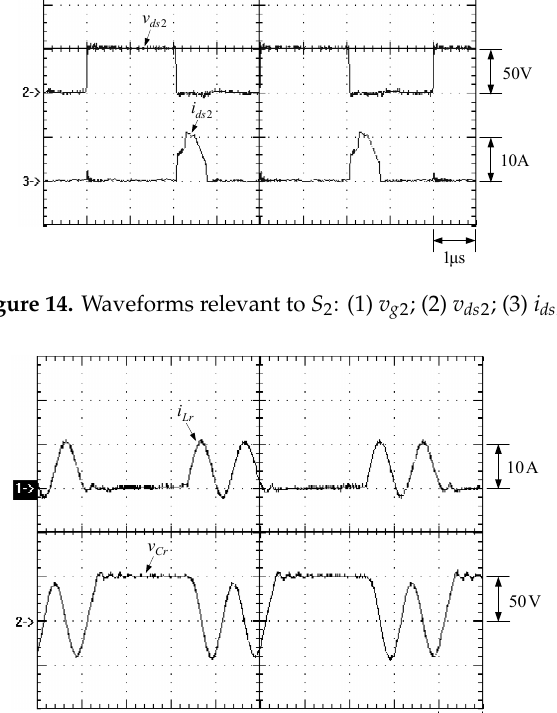
Figure 15. Resonant current i Lr and resonant voltage v Cr .